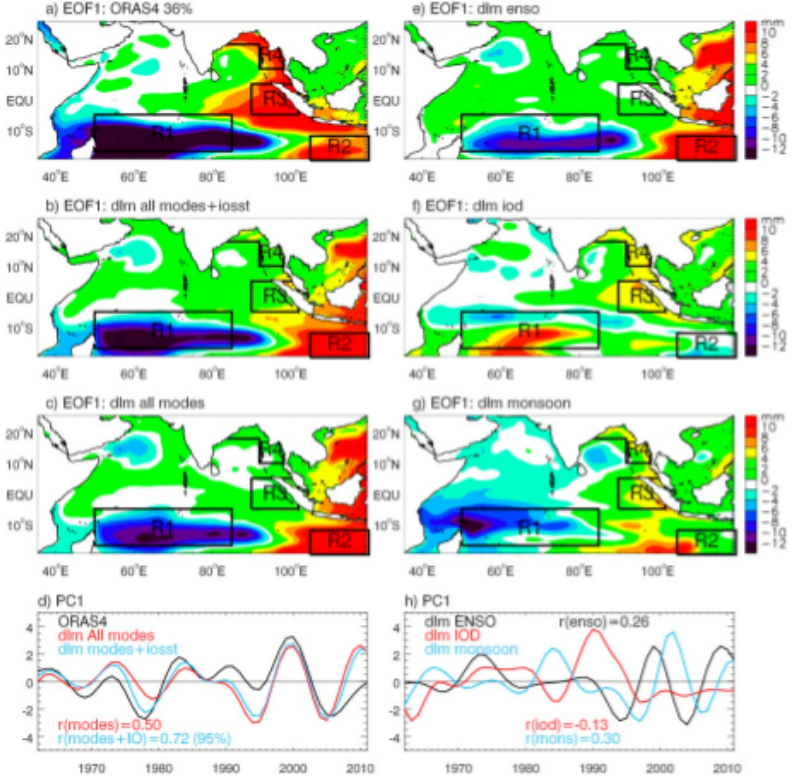
Figure 10. The EOF1 of the 8 year low-passed May–October mean SLA over the tropical Indian Ocean for the period of 1962–2011 from ( a ) ORAS4 data; ( b ) DLM simulation from the sum of all modes and IOSST (ENSO + IOD + monsoon + IOSST); and ( c ) DLM simulation from all modes (ENSO + IOD + monsoon); ( d ) PC1 for ORAS4 (black), all modes + IOSST (blue) and all modes (red); ( e – g ) are the same as ( c ) except for the DLM simulation from ENSO, IOD, and monsoon, respectively; ( h ) same as ( d ) except for the PC1 of ENSO (black), IOD (red), and monsoon (blue). The correlation coefficients shown in ( d , h ) are with the observed ORAS4 PC1 (the black curve of panel ( d )). This figure is the same as Figure 9 except for the northern summer (May–October